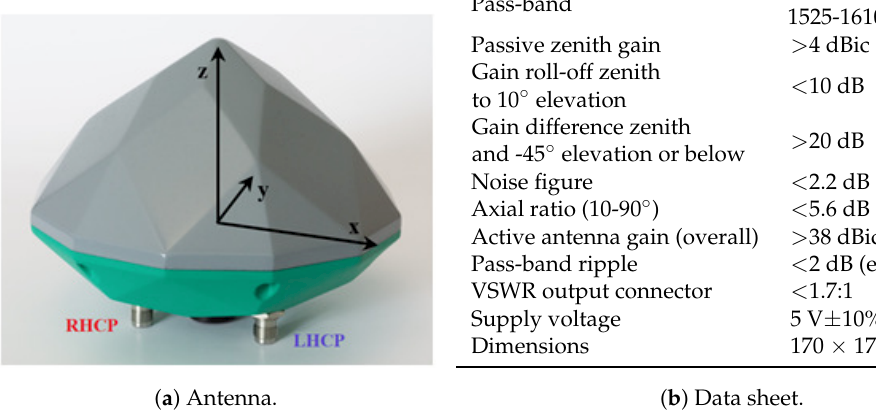
Figure 1. Developed 2pol antenna within the framework of the FANTASTIC project ( a ) and its main characteristics ( b